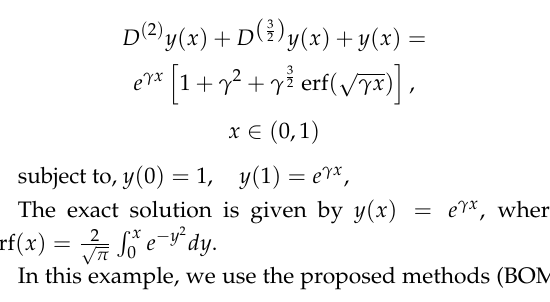
Fig. 2. a) Comparison exact solution and